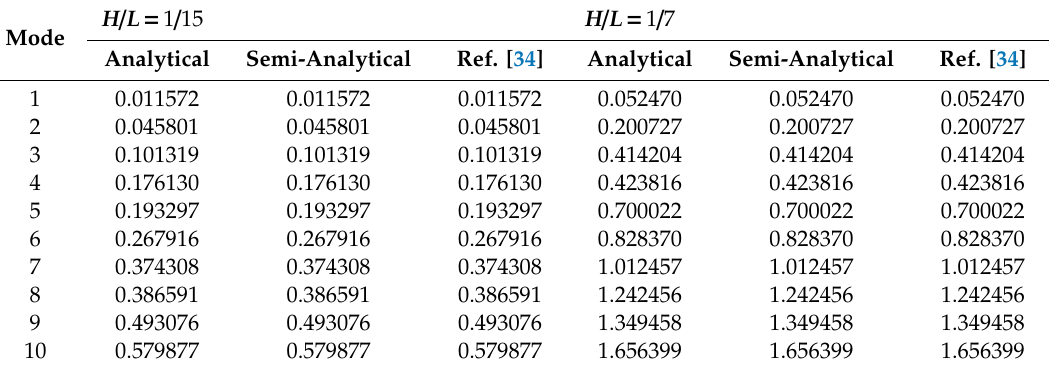
Table 1. Non-dimensional frequencies Ω for S-S FGM straight beams ( α = 0.5).